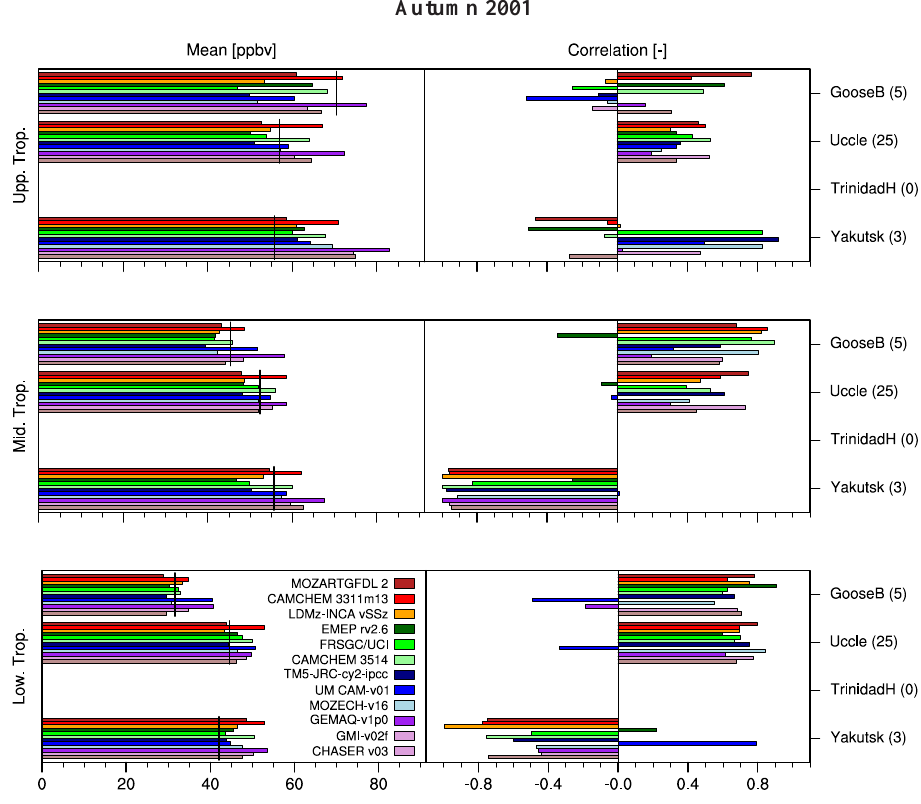
Fig. 6. Measured and model-calculated ozone (ppb) in autumn (September, October, November) for the lower troposphere (900–700hPa), middle troposphere (700–500hPa) and upper troposphere (500–300hPa) for the selected ozonesonde sites. Concentrations to the left (solid lines crossing the model calculations are measurements), correlations to the right. The numbers behind the site name refer to the number of soundings available for comparison in the Autumn. GooseB. is short for Goose Bay, TrinidadH is short for Trinidad Head.